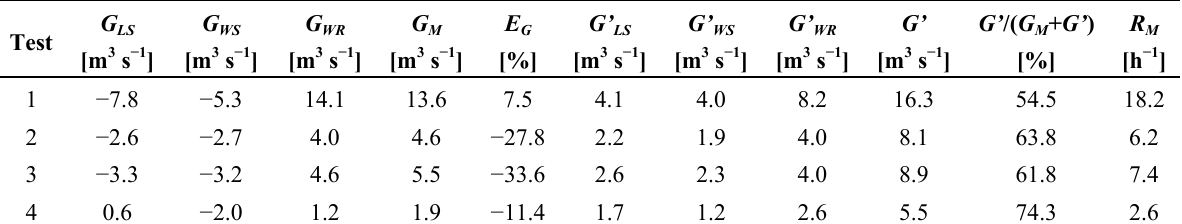
Table 2. Ventilation volumetric flow rates through each vent opening calculated from Equation (13) with values of air velocities u * corrected with wind speed: windward side , leeward side G and windward roof G . Turbulent component of the volumetric G WS LS WR flow rate G ’ from Equation (14). Error in the calculation of ventilation flow rates E air exchange rate R M